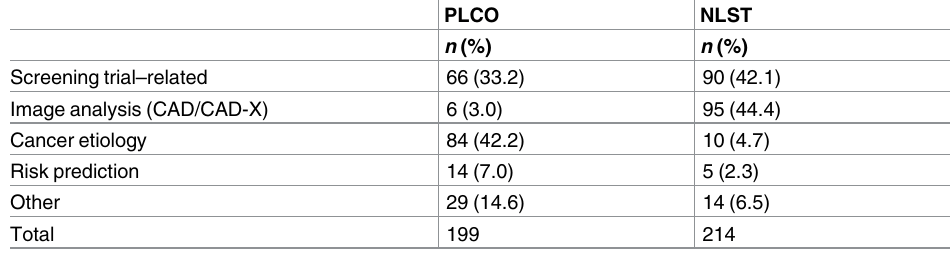
Table 3. Approved proposals by subject